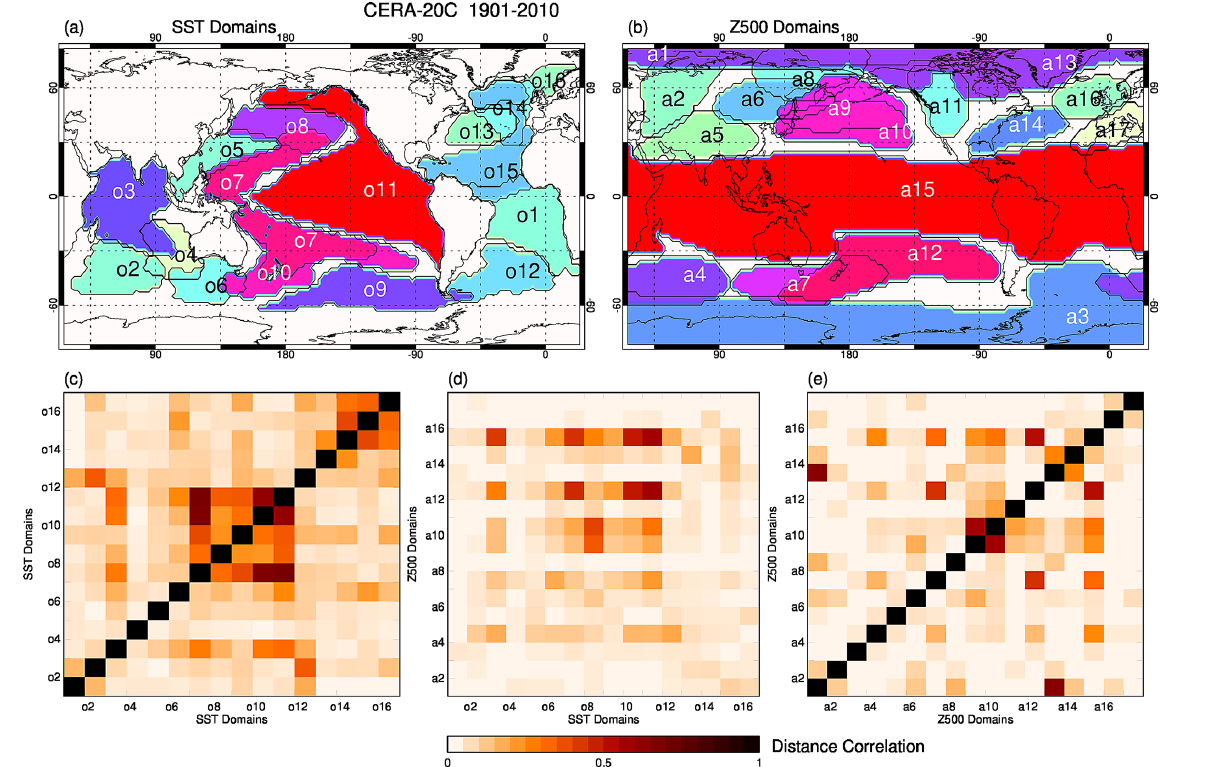
Figure 2. Domains of the CERA-20C ensemble mean (a) SST and (b) Z500 fields over the time period 1901–2010 (arbitrary colours). Maximum lagged distance correlation links between (c) SST and (e) Z500 domains and (d)